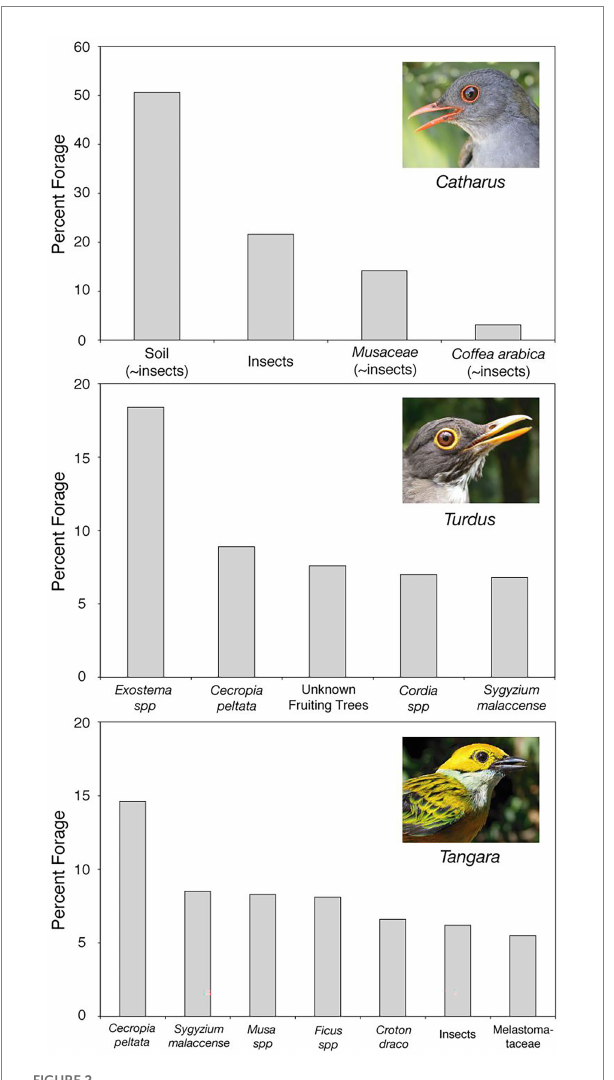
FIGURE 2 The relative percentage of foraging observations on common food resources (each type comprising >5% of all total foraging observations for three of the four bird species examined in this study). No foraging data were collected for Mionectes . Data are from Şekercioğlu et al., 2007.